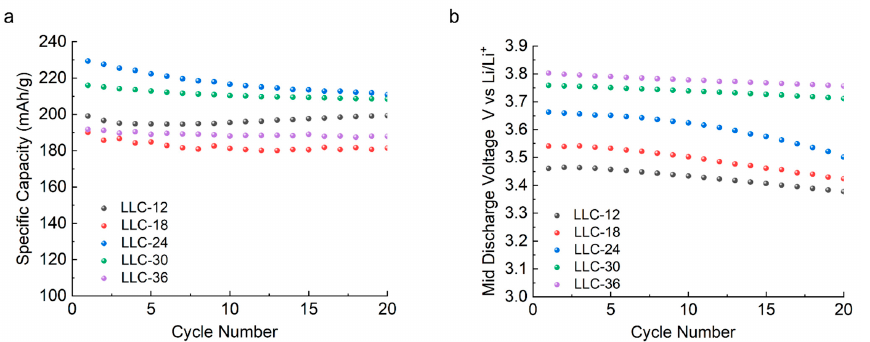
Figure 5. ( a ) Specific discharge capacity and ( b ) average discharge voltage profiles of the investigated samples as a function of cycle numbers in a voltage range of 2.0–4.6 V under a C/5 rate. Cyclic voltammetry (CV) was performed on all LLCs to study the oxidation and re- duction in the cathode material during cycling. Figure 6 plots the specific current as a function of voltage for the first six cycles of each sample. The reaction peaks at approxi- mately 3.25 V are related to the oxidation of Mn 3+ to Mn 4+ from the spinel phase in LLC − 12, LLC − 18 and LLC − 24. During the first charging process, all the LLCs samples showed ox- idation peak at approximately 4.70 V, which originates from the Li ion migration from the